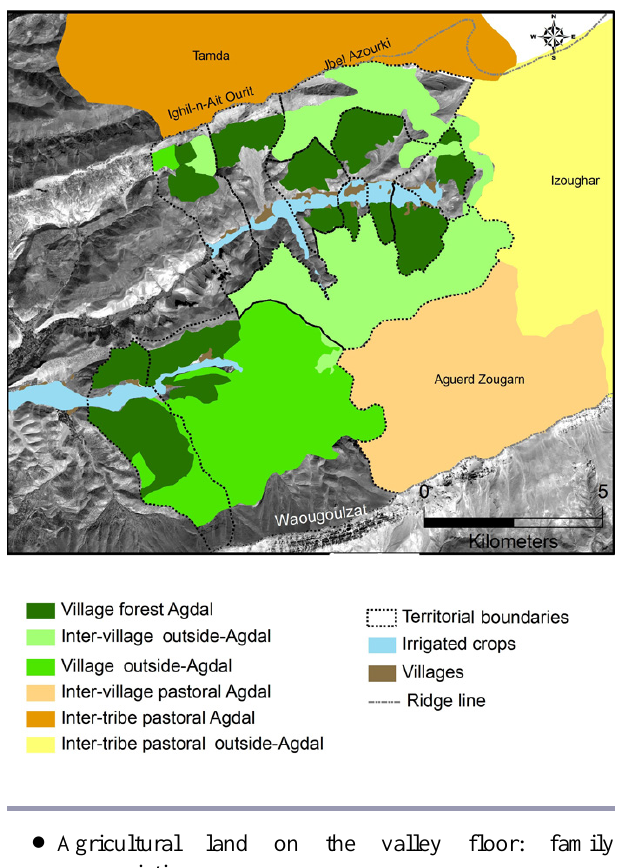
Fig. 2 . Segmentary level control and territorial organization of the upper valley of the Aït Bouguemmez (source: Auclair and Hammi